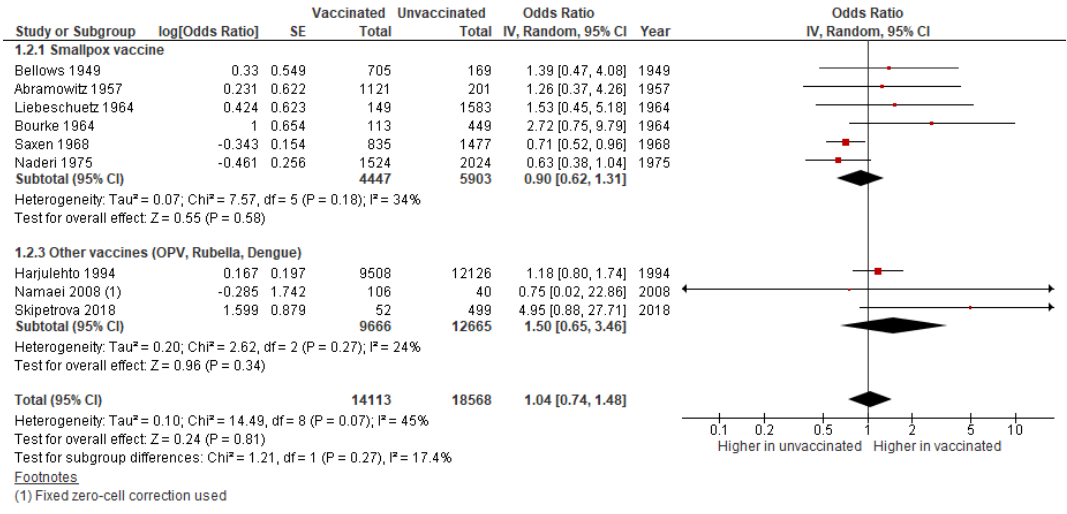
Figure 3. Meta-analysis of the association between maternal immunization and stillbirth. Forest plot showing the effect of immunization during pregnancy on the odds of stillbirth, subgrouped by vaccine.